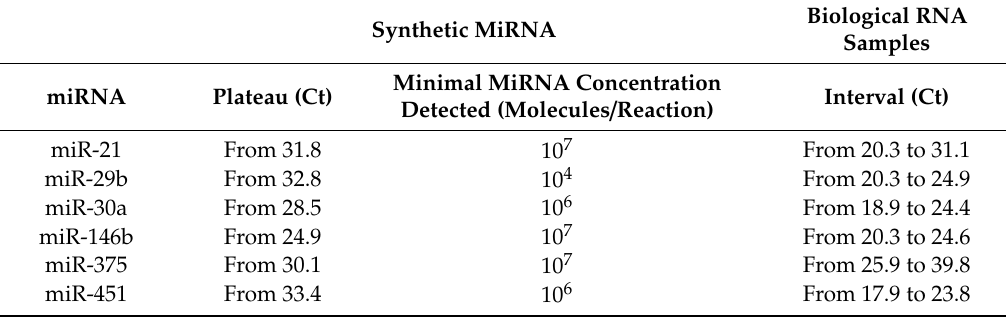
Table 1. Analytic properties of spec-TT RT-qPCR system for miRNA detection.